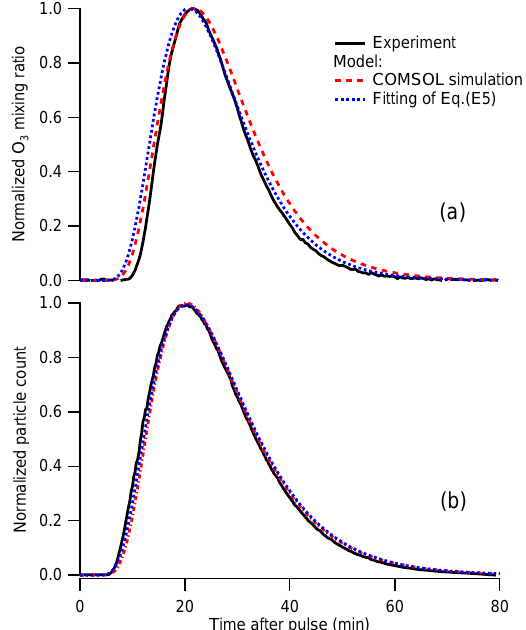
Figure 13. Comparison of experimentally determined RTD of (a) O 3 vapor molecules and (b) polydisperse ammonium sulfate particles to optimized simulation results employing an eddy-like diffusivity ( D e ) in the Taylor dispersion model. The COMSOL sim- ulation employs an optimal D e values of 4 . 5 × 10 − 4 m 2 s − 1 for O 3 and 6 . 0 × 10 − 4 m 2 s − 1 for particles. The fittings of Eq. (E5) em- ploys the same optimal D e , as well as an optimal average velocity ( U avg,fit ) of 2 . 1 × 10 − 3 ms − 1 and an optimal characteristic resi- dence time ( τ c , cyld,fit ) of